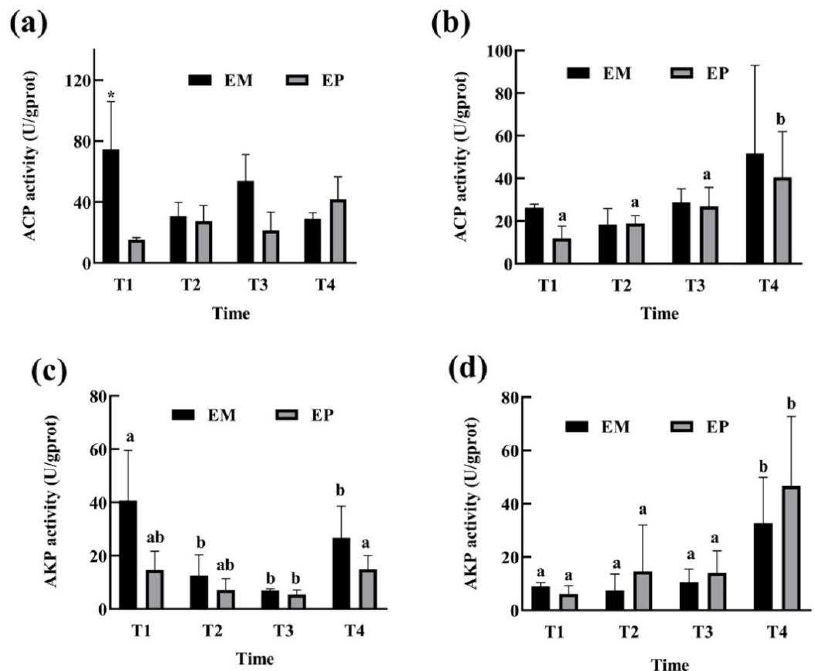
Figure 2. Differences in activities of ACP in ( a ) female and ( b ) male crabs and differences in AKP activity in ( c ) female and ( d ) male crabs between the EM and EP groups at different time points. Data are means ± SD. * indicates a statistically significant difference between the EM and EP groups at T1. Different lowercase letters indicate significant differences among different time points in the same group ( p < 0.05).